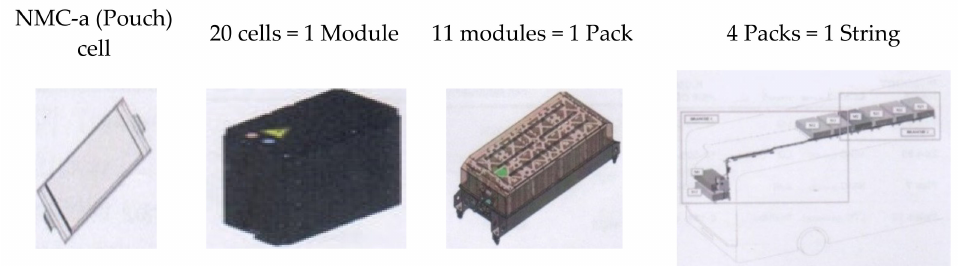
Figure 5. The installations of the NMC-a (pouch) type LIB.